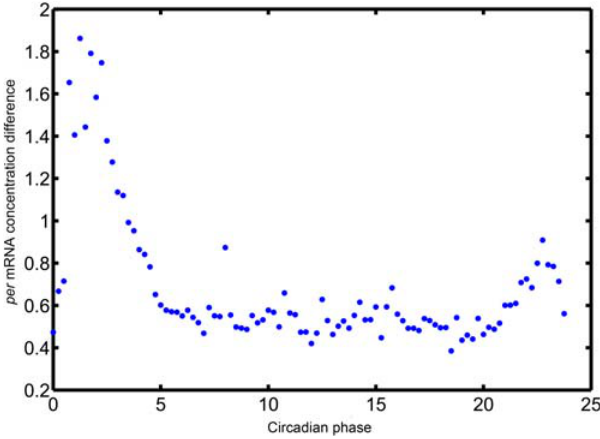
Figure 8. Phase specific differences in cell division induced circadian system alterations in the presence of noise. Light dark cycles and transcriptional inhibition cycles initiated at different circadian phases (with light onset as the reference) were imposed onto circadian models, and the Per mRNA concentration differences at light onset before and after transcriptional inhibition were calculated. Results from 100 simulations were averaged.